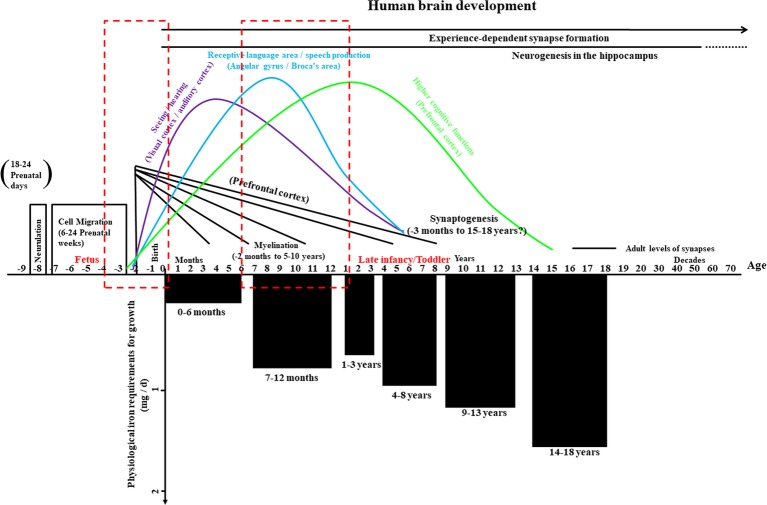
Overview of human brain development and physiological iron requirement for growth in infancy and childhood. The upper part of this graph illustrates the important prenatal events – such as the formation of the neural tube (neurulation) and cell migration, critical aspects (seeing/hearing, receptive language area/speech production, and cognitive functions) of synapse formation and myelination beyond year three, and the formation of synapses based on experience – as well as neurogenesis in a key region of the hippocampus throughout much of life. Periods with high risks for alterations in iron metabolism during early human brain development are highlighted with dashed red boxes. The lower part of the graph shows the physiological iron requirements for growth in different stages during infancy and childhood. Chart adapted and appropriated permission have been obtained from references (Thompson and Nelson, 2001; Georgieff and Innis, 2005; Hider and Kong, 2013).